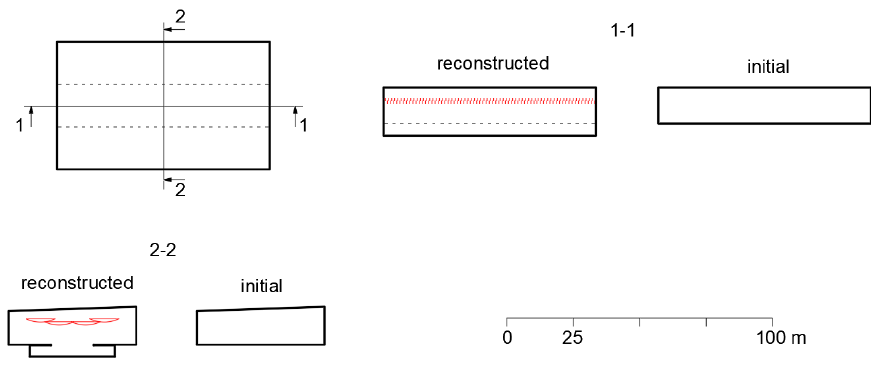
Figure 8. Change of the food court space and location of sound-absorbing baffles (red) in the food court FC2.